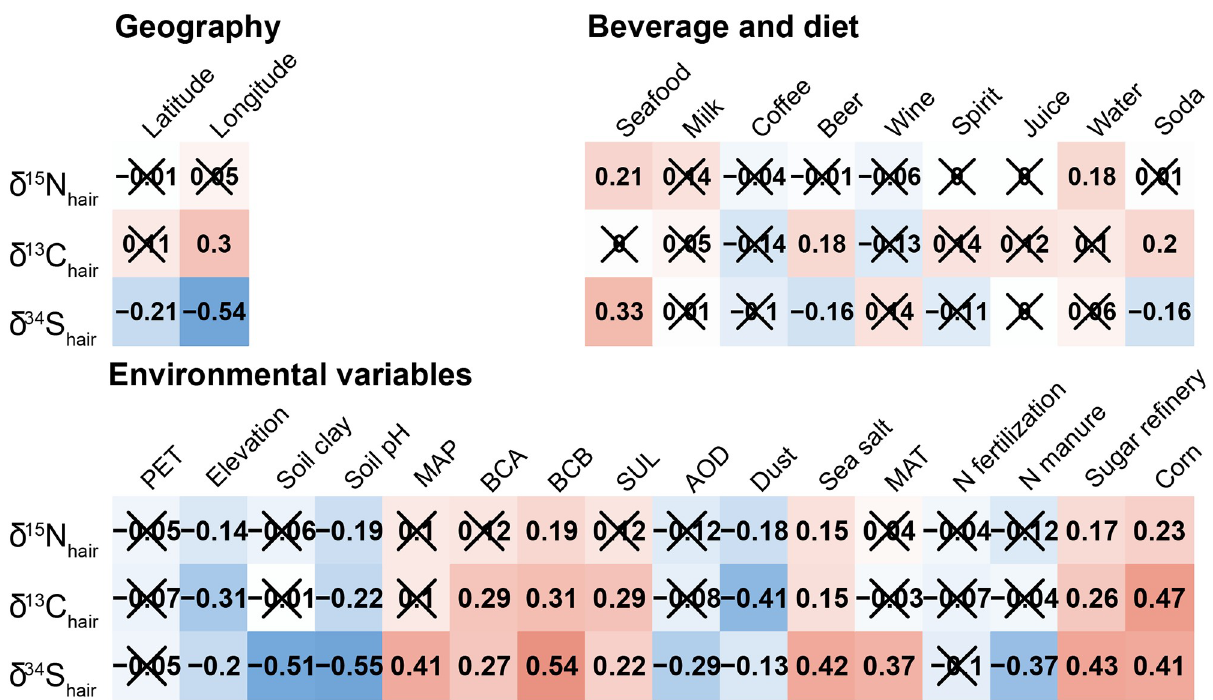
Fig 3. Pearson correlation coefficient between isotopic data in hair and the continuous dietary choice, geographic and environmental variables. Red and blue squares indicate significant positive or negative correlation (p-value < 0.01) whereas crosses indicate no significant correlation (p- value >